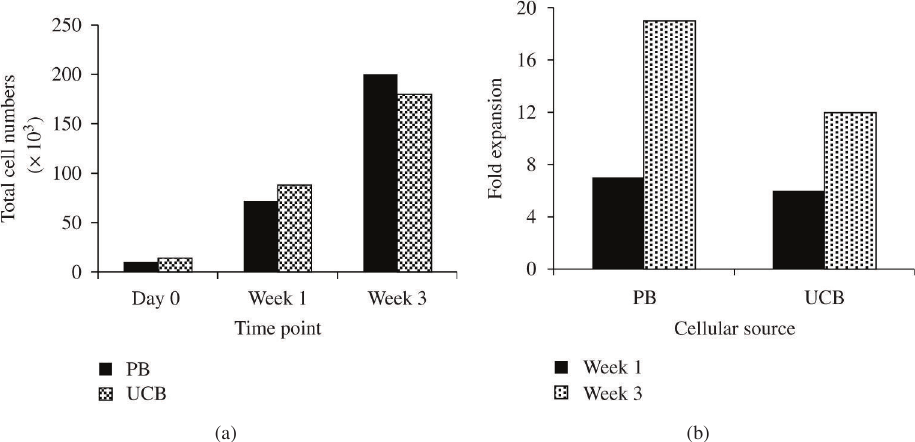
FIGURE 4: Ex vivo expansion of CD3 + CD4 + CD25 + CD127 lo nTreg from adult peripheral blood (PB) and umbilical cord blood (UCB)-derived mononuclear cells. (a) Total cell numbers of cultured nTreg. FACS- sorted CD3 + CD4 + CD25 + T cells were cultured with Rapamycin and rhIL-2 for 21 days. (b) Fold expansion (from baseline absolute number at start of expansion) of ex vivo expanded nTreg from PB and UCB. are the two main cytokines used to augment Signal 3, prevent apoptosis, and possibly to sustain of FOXP3 expression. Rapamycin, a small molecule inhibitor of the mTOR-AKT pathway, promotes growth and selective expansion of both human and murine CD3 + CD4 + CD25 + FOXP3 + Treg [61–63].